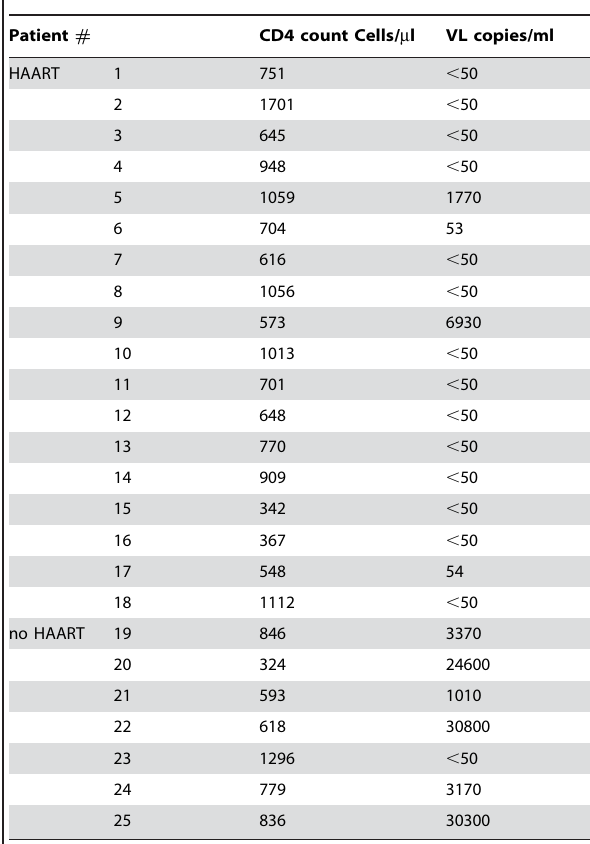
Table 1. Patients clinical